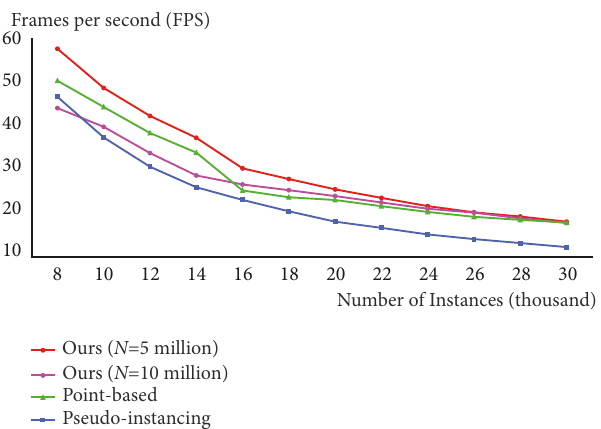
Figure 7: The performance comparison of our approach, pseudo-instancing technique, and point-based technique over different numbers of instances. Two values of 𝑁 are chosen for our approach ( 𝑁 = 5 million and 𝑁 = 10 million). The FPS is averaged over the total of 1,000 frames.